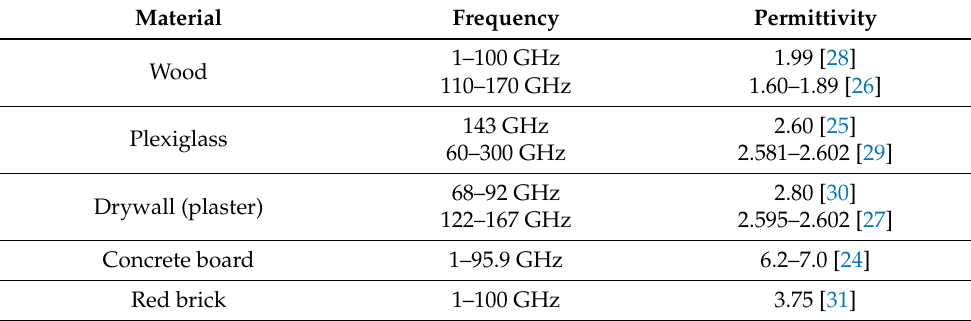
Table 3. Permittivity Review of Indoor